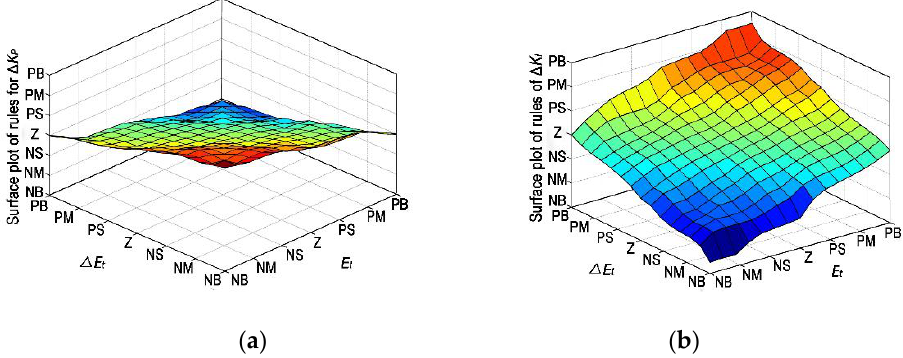
Figure 8. Fuzzy rules for control of steering tracking system: rule surface of ( a ) Δ K P and ( b ) Δ K I .